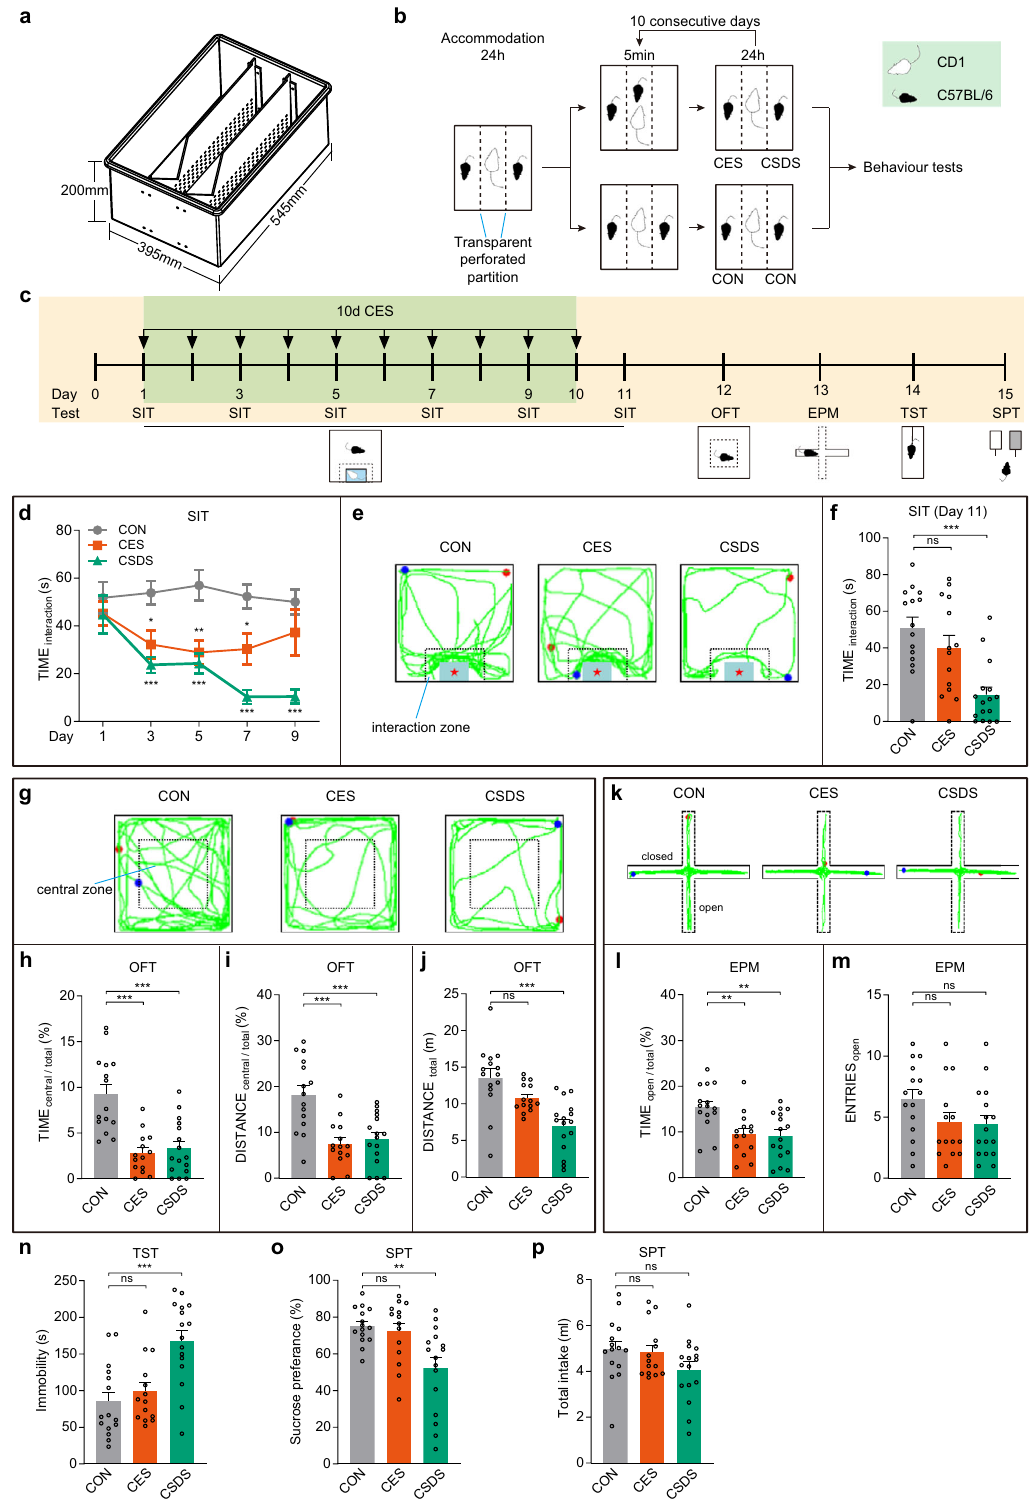
Because of the dif fi culties of in vivo electrophysiology in analyzing and AAV2/9-tyrosine hydroxylase (TH)-Cre into the VTA area of the neural activity of normal-moving mice in behavioral testing, we wild-type C57BL/6 mice (Fig. 2g, h). After two weeks ’ rest, optic- fi ber investigated the dynamics of VTA DA neuron activation and their role cannula was implanted over the same site (Fig. 2g, h). GCaMP6s in anxious behaviors by in vivo fi ber photometry, which could record expression in the VTA DA neurons was con fi rmed post hoc by colocalization with TH (Fig. 2i; Supplementary Fig. 3a, b). We found intracellular calcium (Ca 2 + ) transients in behaving mice. The that the onset of anxiety-inducing events, in this case, the target mice genetically encoded Ca 2 + indicator GCaMP6s was expressed in received emotional stress by observing their conspeci fi c partners VTA DA neurons by stereotaxic infusion of AAV2/9-DIO-GCaMP6s NATURE COMMUNICATIONS| (2022) 13:577